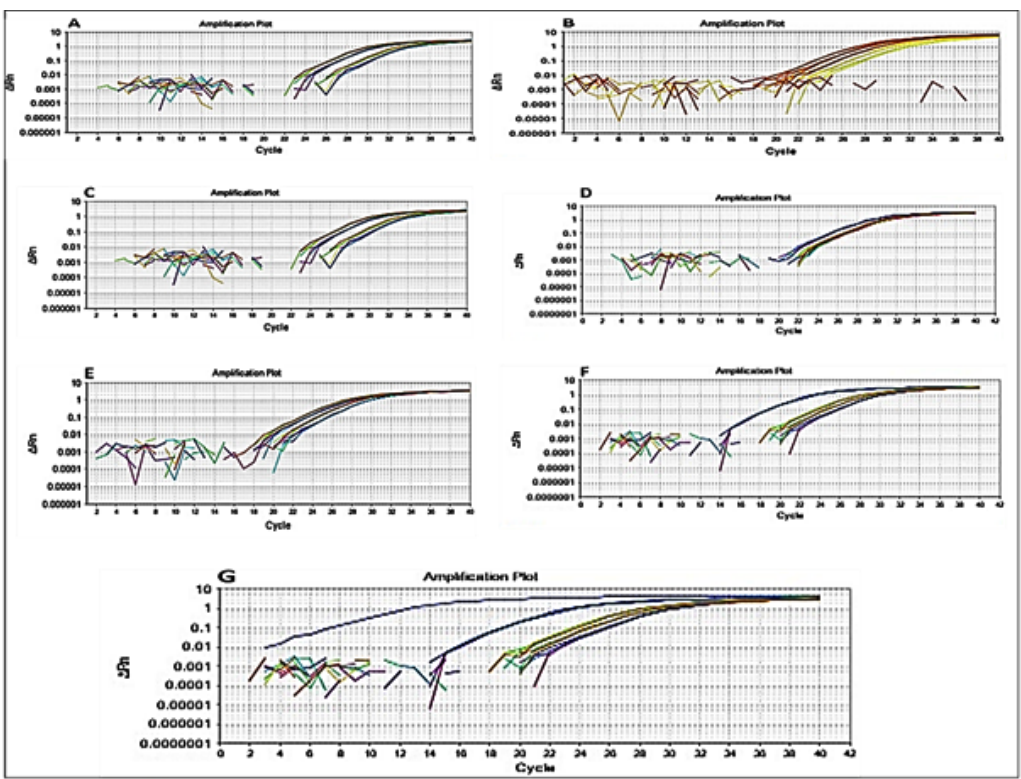
Fig. 6. Uniplex SYBR®Green Real time PCR amplification plot for detection of certain 6 virulence genes in E. faecalis strains. A: asa1 ; B: GelE ; C: cylA ; D: esp ; E: hy1 ; F: vanA , and G: vanB